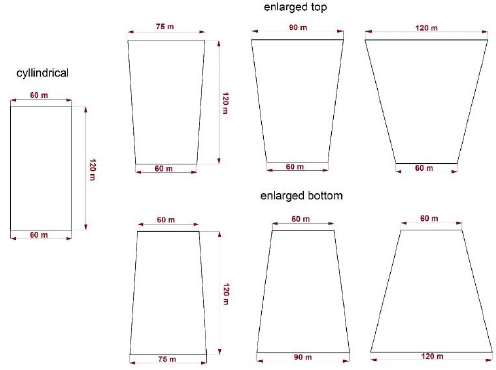
Figure 3. The initial shapes and dimensions of the caverns.